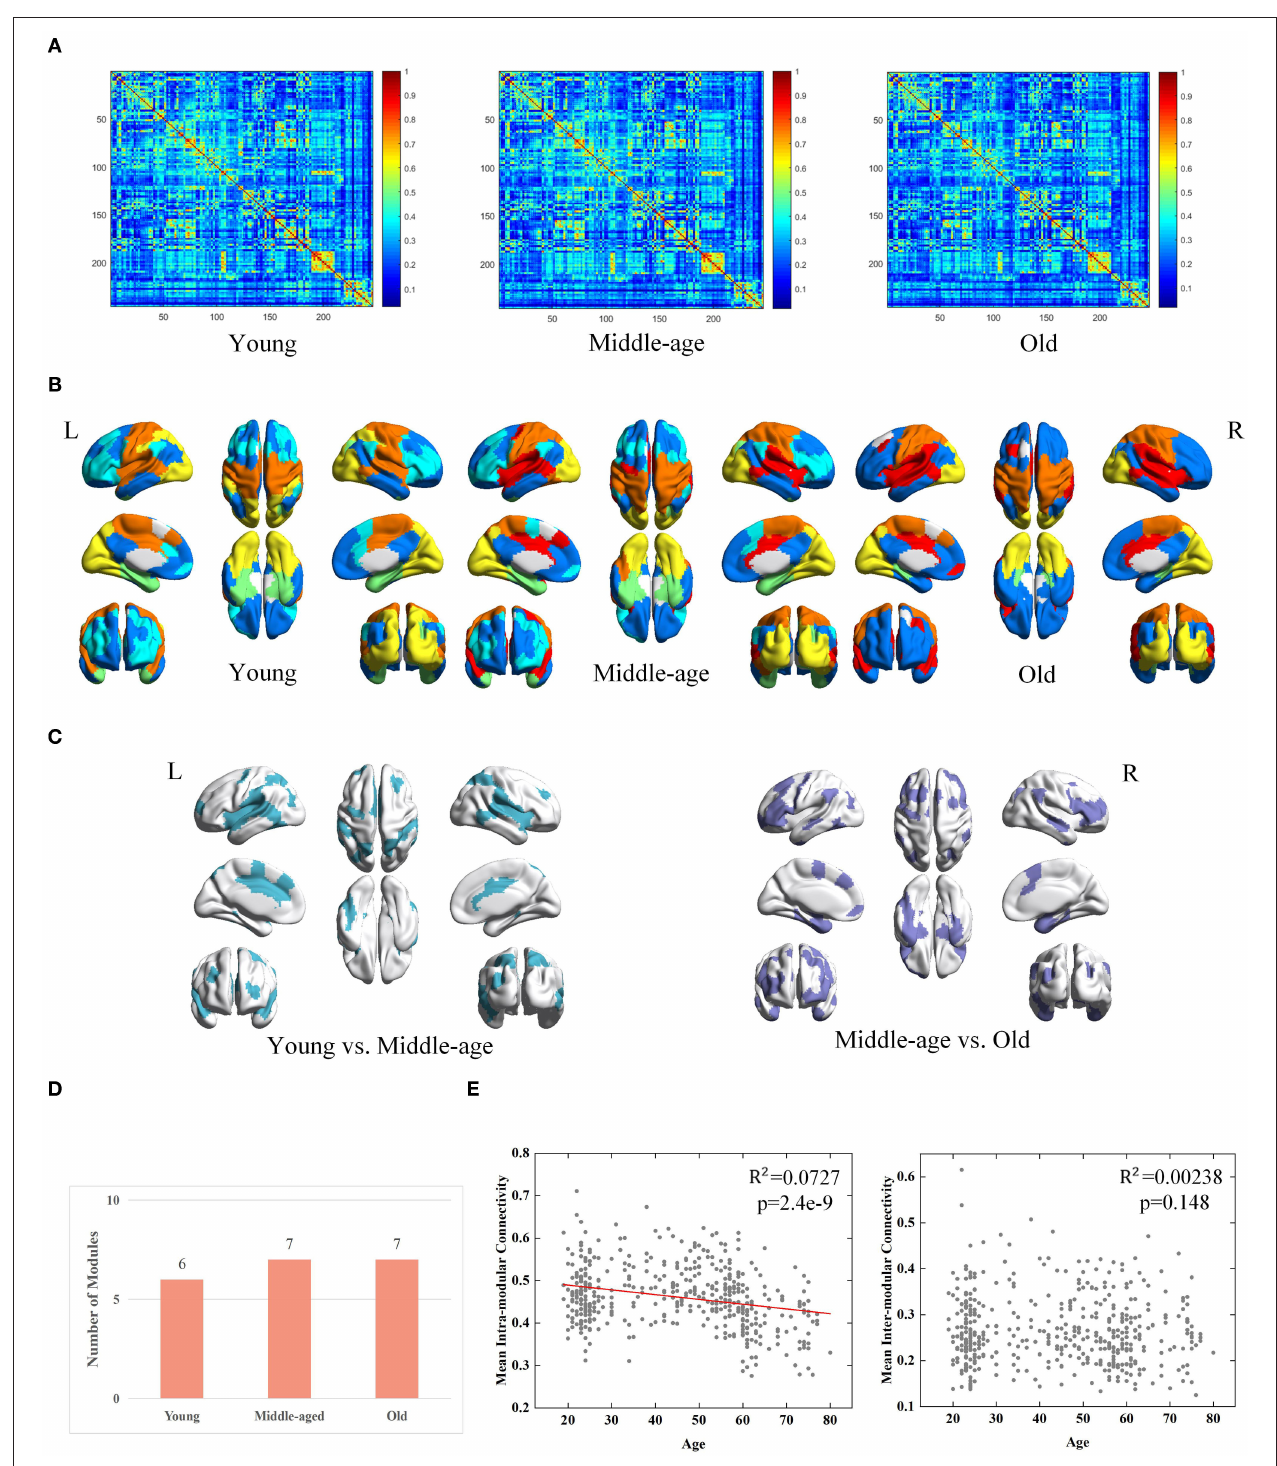
FIGURE 4 | Age-associated differences in functional brain networks across three groups derived from conventional method, including (A) average-based group-level networks, (B) modular structures (different colors represent different modules), (C) Brain regions belonging to different modules (young group vs. middle-age group and middle-age group vs. old group), (D) number of modules, and (E) age-associated trajectories of the mean intra- and inter-modular connectivities.